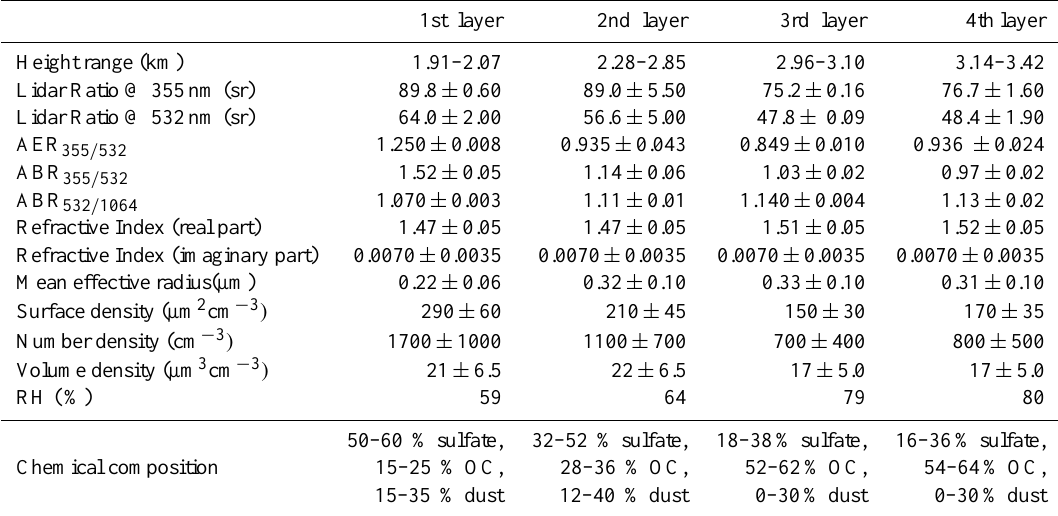
Table 3. Mean optical, microphysical and chemical properties of aerosols, as well as the relative humidity RH (%) at each layer, retrieved at four specific layers on 2 April